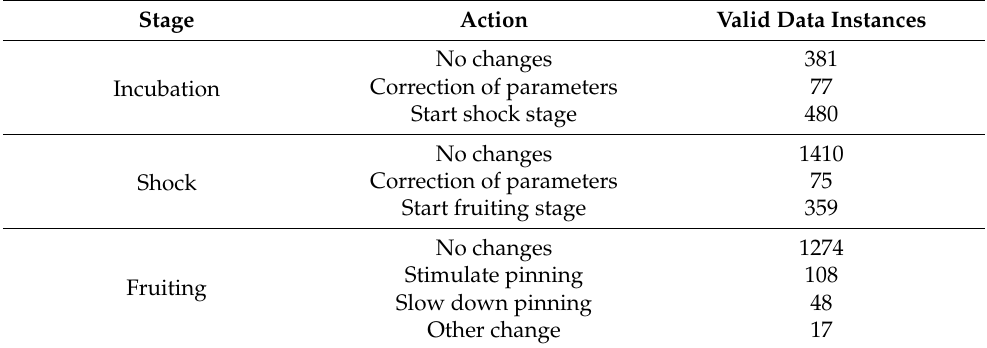
Table 3. Distribution of the prepared dataset instances by growth stage and stage actions.